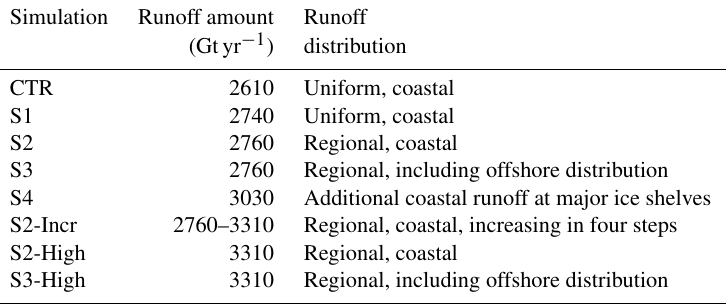
Table 1. Main features of the